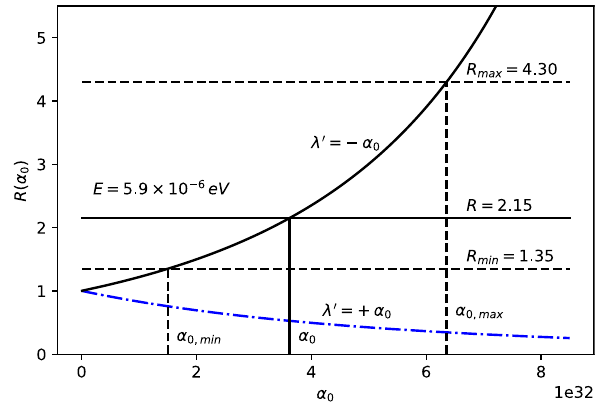
Fig. 4 R vs α for fixed energy E = E 12 (cid:2) 5 . 9 × 10 − 6 eV η = + 2 α 0